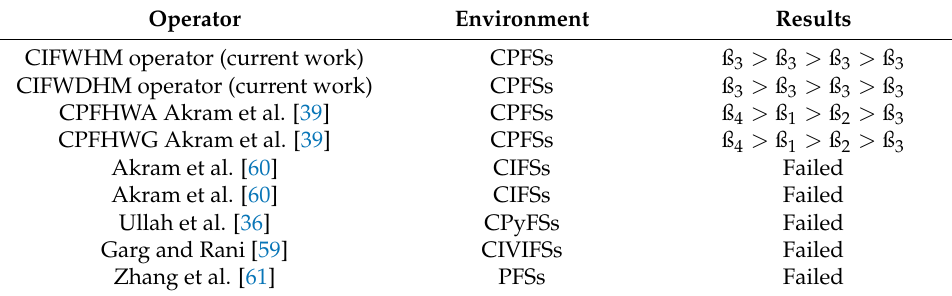
Table 6. Results of the comparative study.